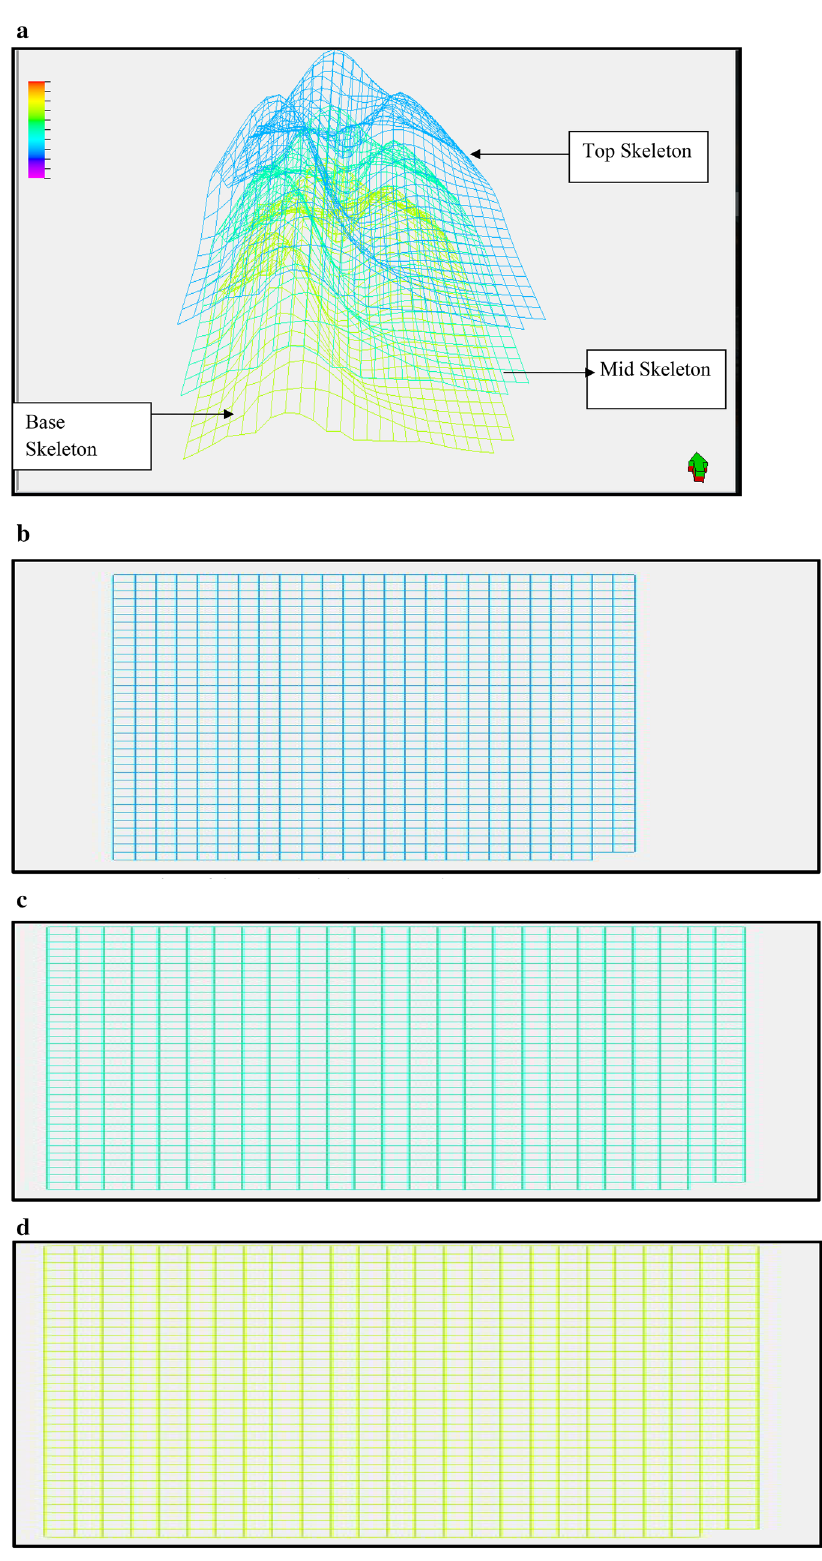
Fig. 2 a Skeletal framework of the reservoir showing the top, mid, and base skeleton. b Map view of the top skeletal frame- work. c Map view of the mid skeletal framework. d Map view of the base skeletal